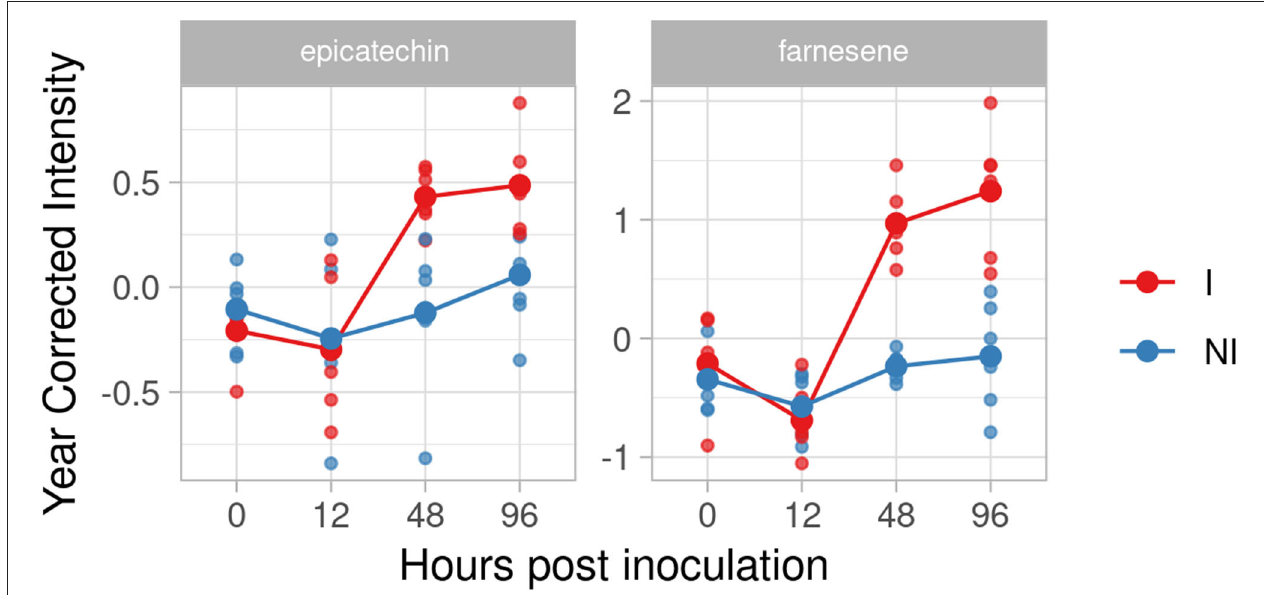
FIGURE 4 | Graphs for specific putative biomarkers of resistance to Plasmopara viticola in inoculated (Red) and not inoculated (Blue) BC4 genotype. Values of the 2 years are reported after subtracting the year’s effect. I, inoculated; NI, not inoculated.